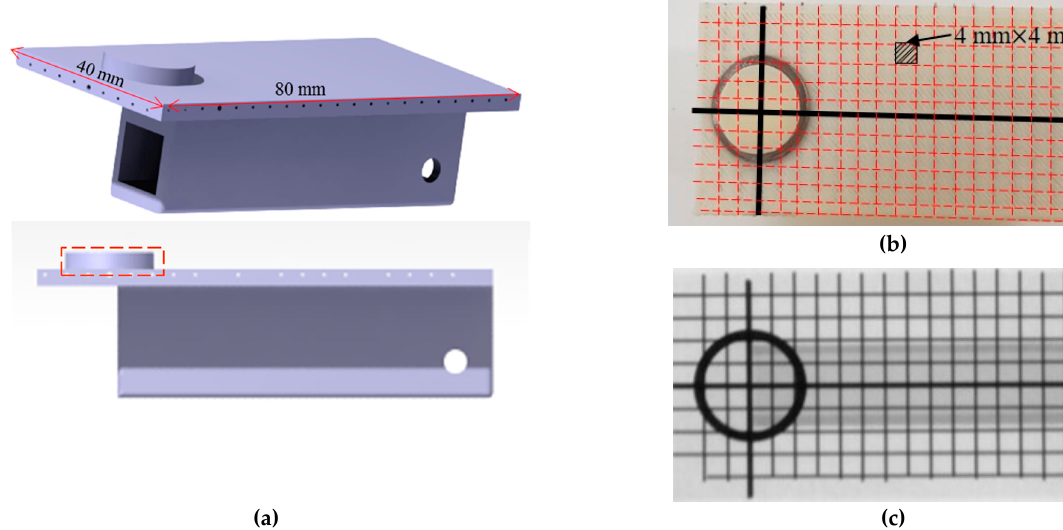
Figure 4. Guiding pattern block of the fine adjustment device. ( a ) 3D model. ( b ) Fabricated prototype (red dotted lines added for the visualization). ( c ) X-ray image of hole jig.